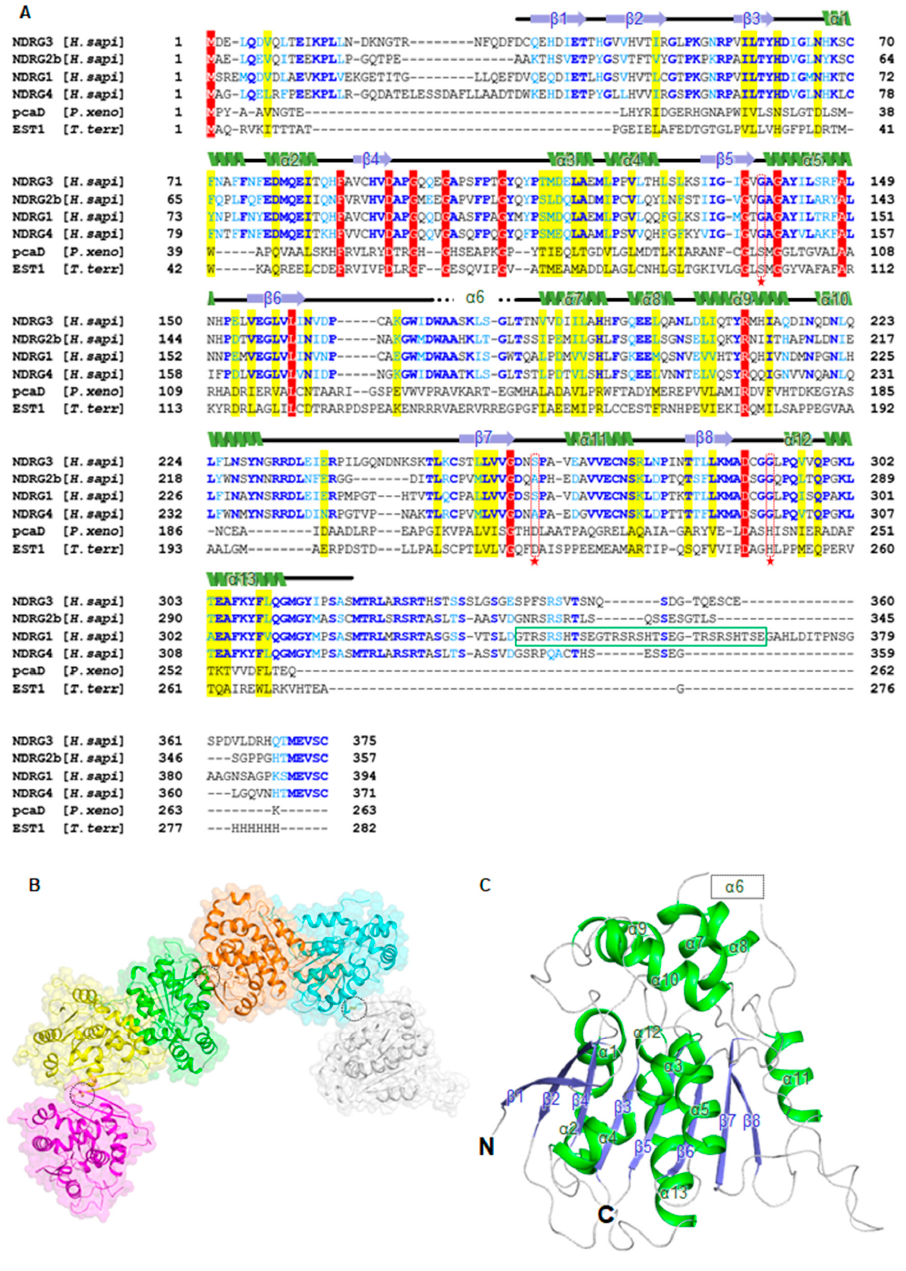
Figure 1. Crystal structure of truncated NDRG3 (residues 29–320, NDRG3 ∆ NC). ( A ) Sequence alignment of human NDRG isoforms and structurally similar α / β -hydrolase fold proteins. The secondary structure of NDRG3 is shown above the sequence alignment. The conserved catalytic triads are marked with red asterisks. Strictly and moderately conserved residues are highlighted with red-shaded boxes, and yellow-shaded boxes, respectively. Blue and cyan-colored residues represent the identical and conserved residues among the NDRG isoforms, respectively. The green box indicates the three decapeptide sequence (GTRSRSHTSE) repeats of NDRG1. Sequences were aligned using the T-Coffee web server [30] . ( B ) NDRG3 Δ NC molecules observed in an asymmetric unit of the crystal. Intermolecular disulfide bonds are shown in stick models and marked with black-dotted circles. ( C ) NDRG3 ∆ NC structure is shown in cartoon representation. α -helices, β -strands, and loops are colored in green, blue, and white, respectively. The disordered region corresponding to helix α 6 of NDRG2 is shown with a black-dashed box and labeled as the helix α